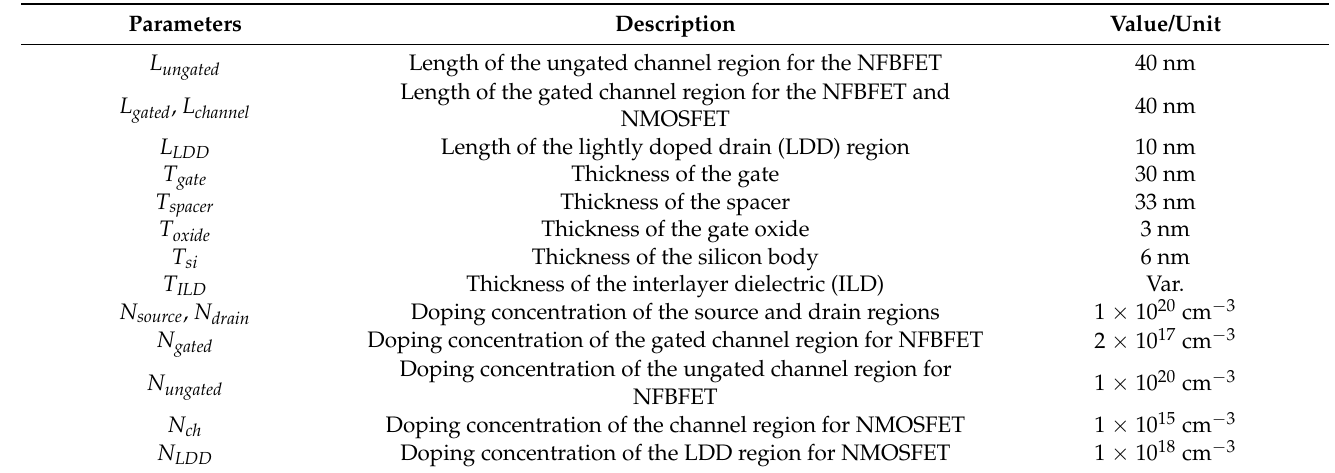
Table 1. Structure parameters of the M3D-FBFET-SRAM